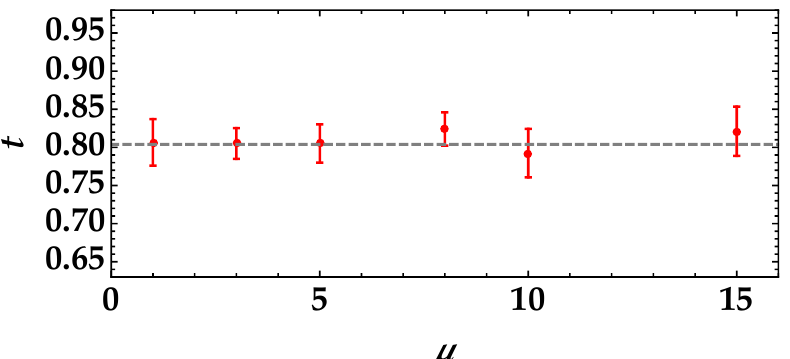
Figure 9. Values of t obtained fitting the data according to Equation (6) as a function of the number of modes, in the case in which the mean number of photons per mode is constant. The gray dashed line represents the expected value t =